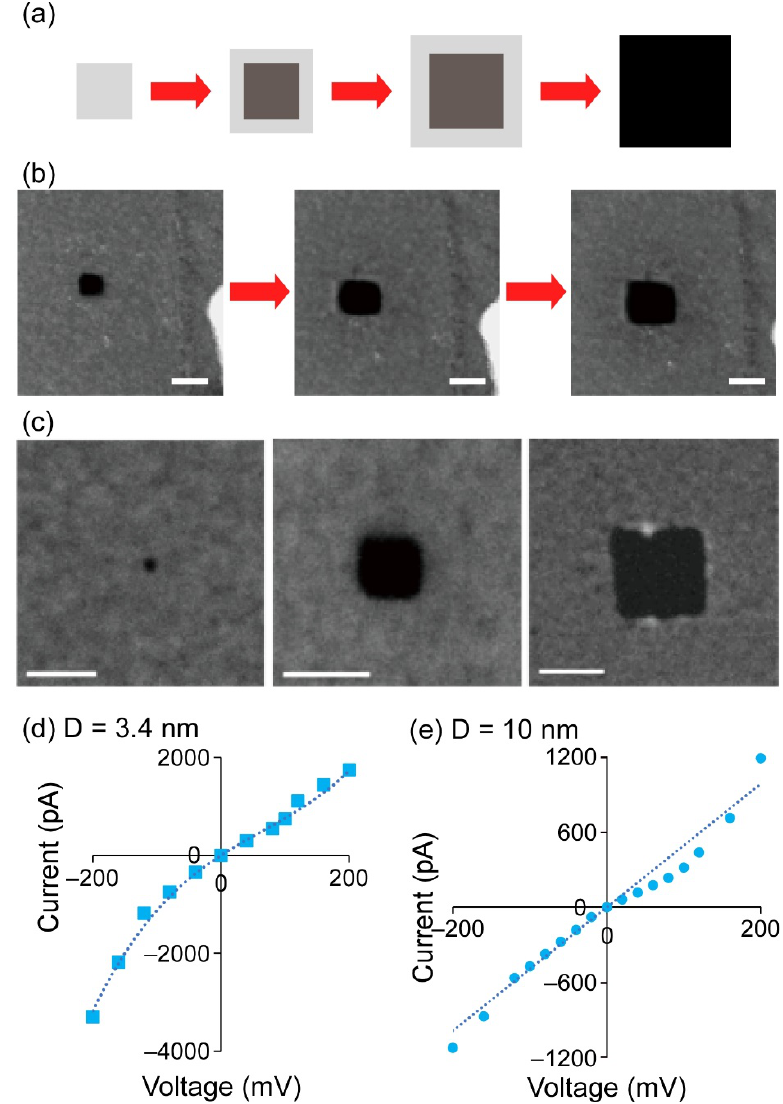
Figure 2. Nanopores fabricated by the STEM EB method. ( a ) The scanning pattern of a focused EB. The EB was initially irradiated over a small area to fabricate a small pore. Then, the scanning area was extended to expand the pore. ( b ) Fabrication processes of a nanopore in a carbon thin film. A small pore was expanded in size by controlling the scan area of a focused EB. The scale bars indicate 20 nm. ( c ) Three different sized nanopores: (left to right) 2.0 nm, 8.5 nm, and 45 nm in diameter. These diameters were calculated by approximating to a circle. I-V curves of nanopores with ( d ) 3.4 nm (in 1 M KCl solution) and ( e ) 10 nm (in 100 mM KCl solution) diameter fabricated by the STEM EB method.